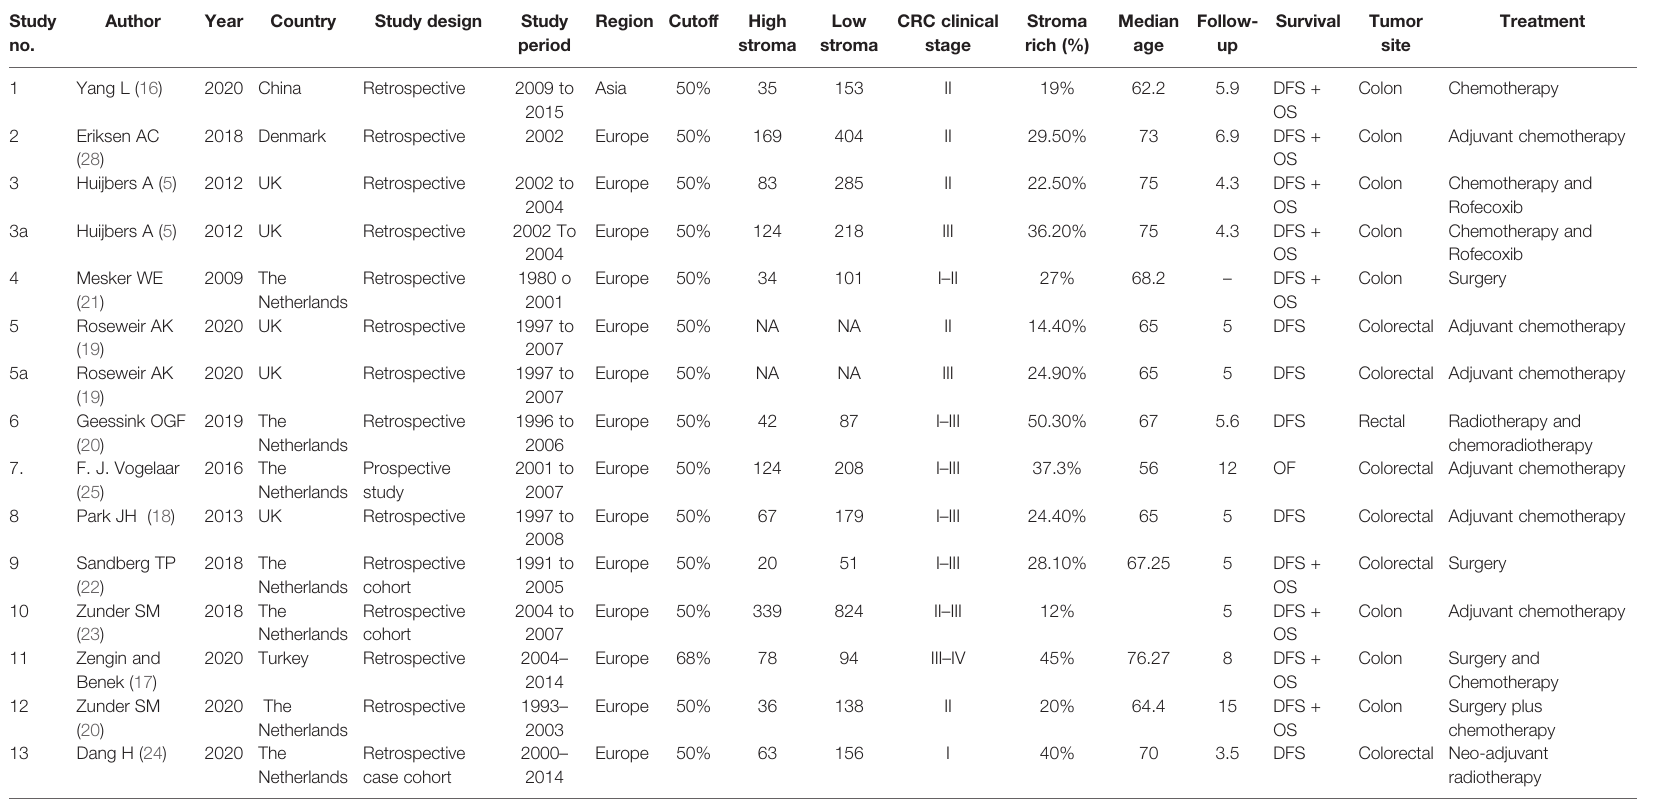
TABLE 1 | Study characteristics of studies included in the systematic review. Study